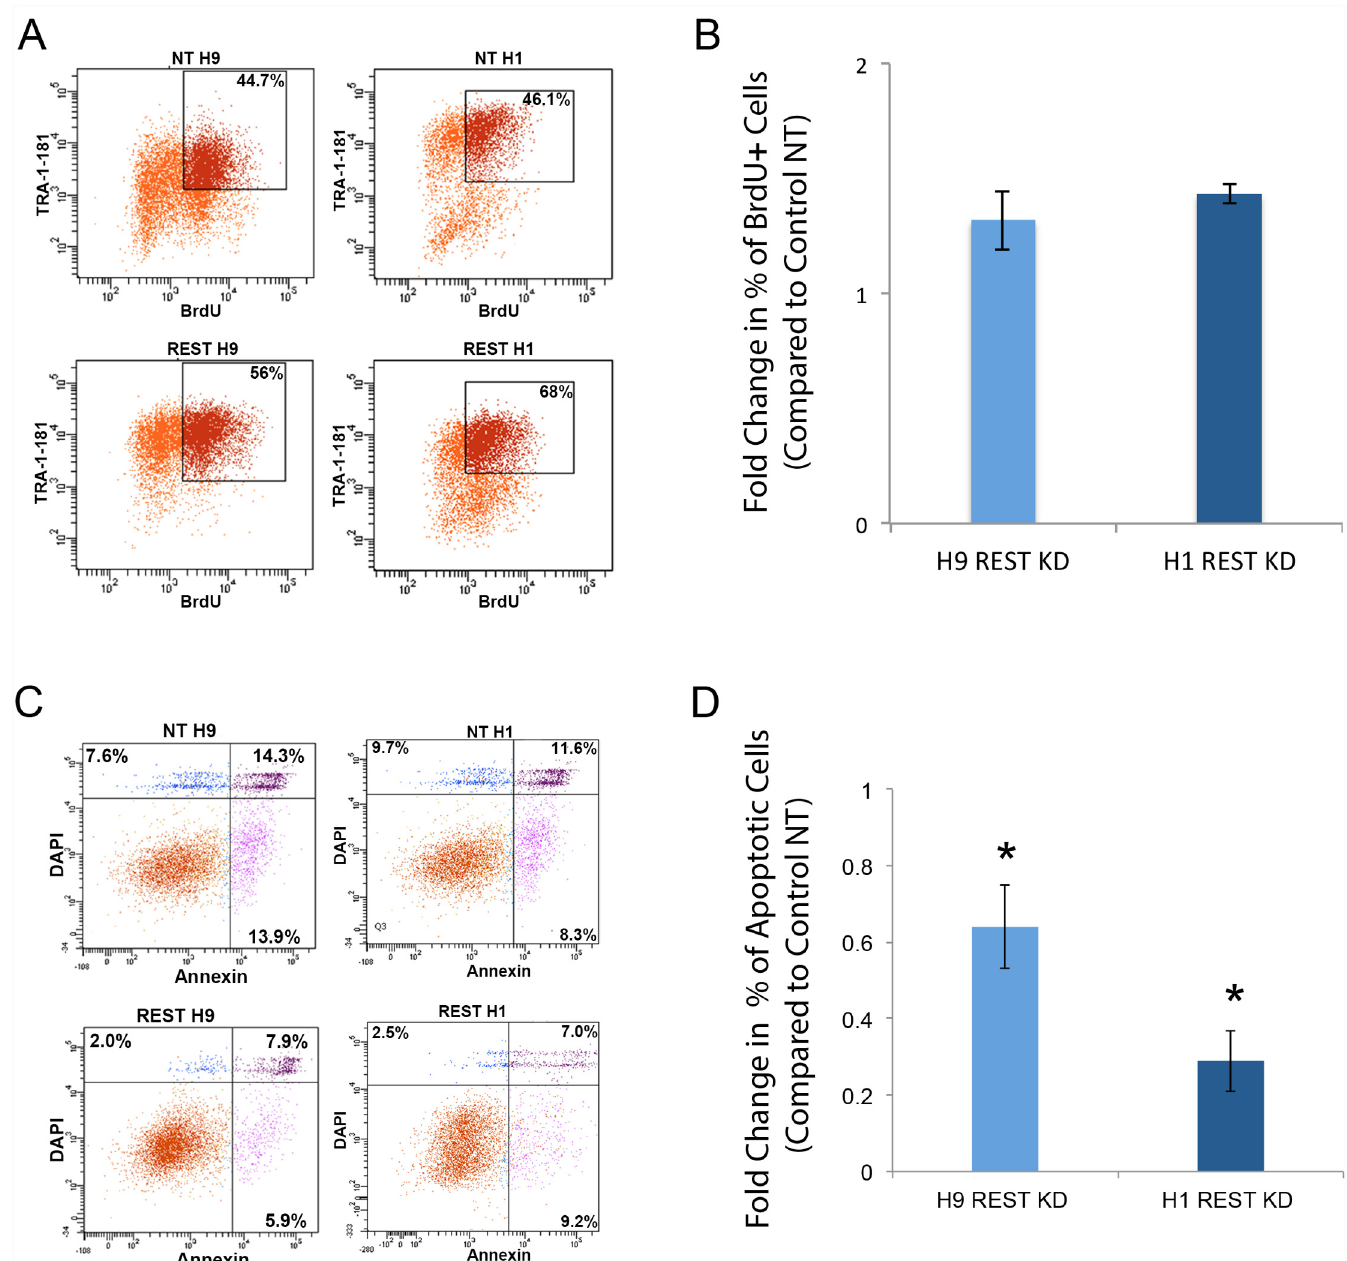
Fig 2. REST KD hESCs have increased survival. A . REST KD and NT hESCs (H1 and H9) were evaluated for BrdU incorporation by FACS analysis for TRA-1-81 and BrdU double positive cells. B . Percentage of TRA-1-81and BrdU positive cells were not statistically significantly different in REST KD compared to control NT cells. Error bars represent standard error of three independent experiments (performed at p52, p54 and p60 for H9 cells, and at p47, p49, and p50 for H1 cells). C . REST KD and NT hESCs (H1 and H9) were evaluated for the percentage of Annexin V and DAPI positive cells by FACS analysis. D . FACS analysis for Annexin V and DAPI staining demonstrated that REST KD hESCs have statistically significant improvements in survival as demonstrated by reduced levels of apoptotic cells (p < 0.032 in H9 and p < 0.002 in H1) compared to control NT hESCs. Error bars represent standard error of three independent experiments (performed at p55, p57 and p59 for H9 cells, and at p55, p56, and p57 for H1 cells) and asterisks denote a p value < .05 using Student ’ s t-test analysis.